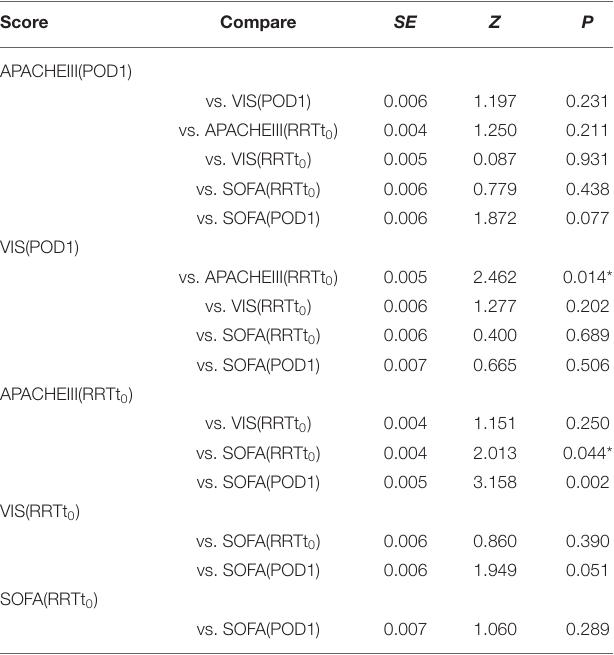
TABLE 5 | Results of pairwise score comparison. TABLE 6 | Results of variable